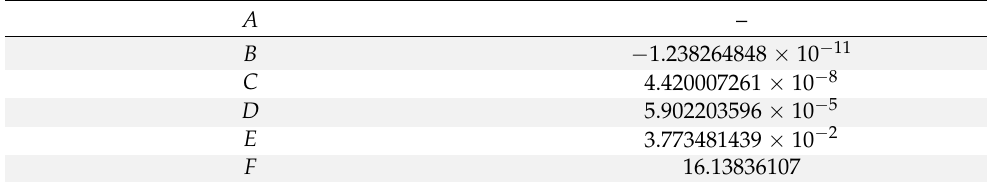
Table 3. Coefficients for Equation (1) for the temperature range 300 K to 1200 K for Ge (J/mol/K).